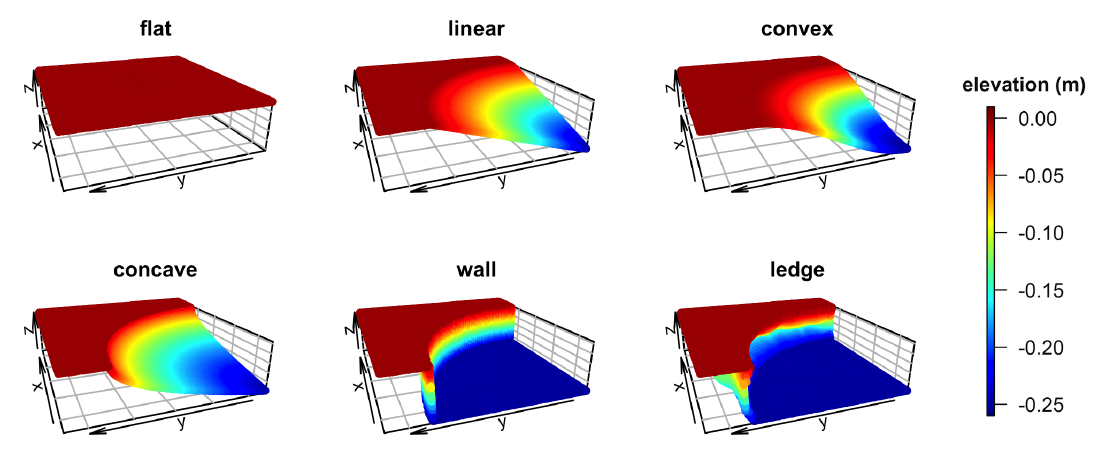
Figure 1. Three-dimensional visualization of six different simulated surface structures: flat, slope, convex, concave, drop and overhanging